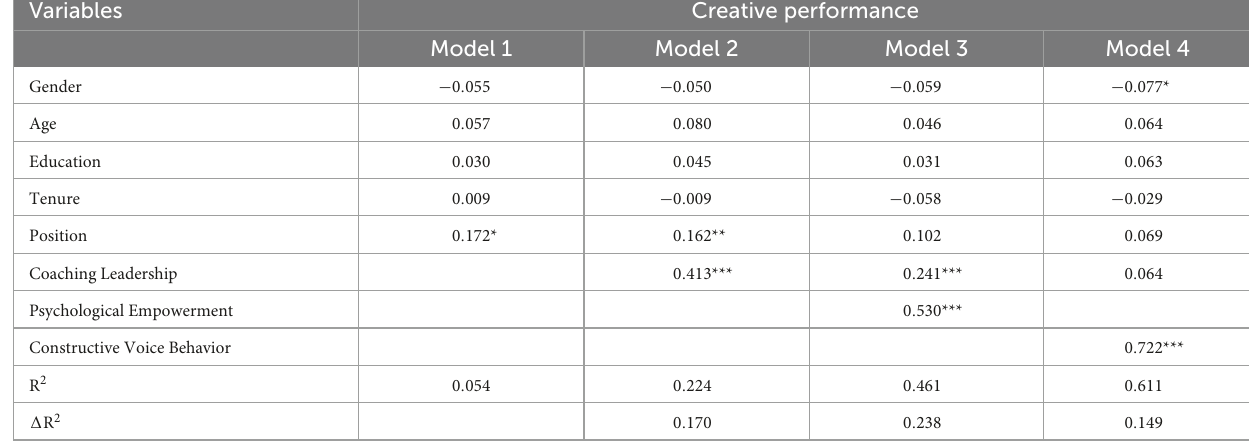
TABLE 3 Results from hierarchical linear regression analysis with creative performance and coaching leadership.